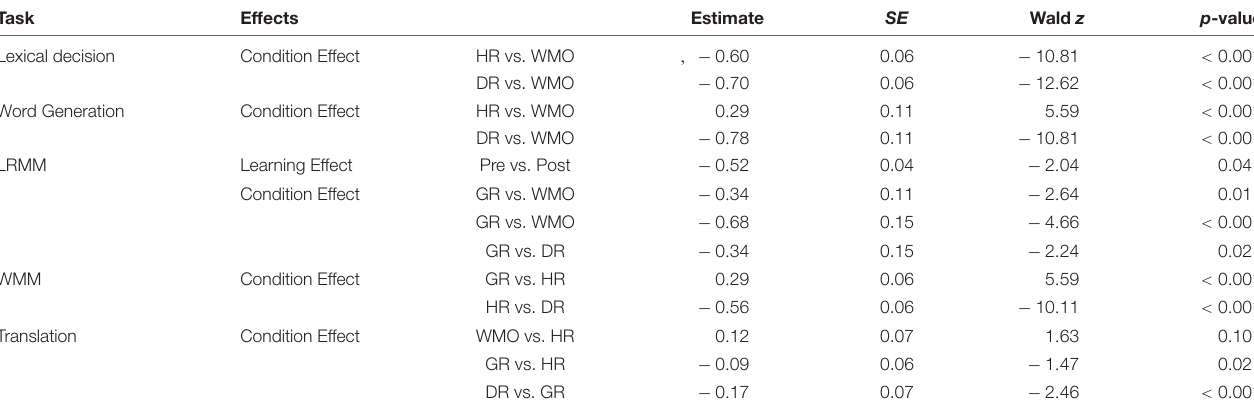
TABLE 3 | Significant fixed effects estimates from mixed Logit model of correctness with pre-planned comparisons of condition as fixed effects for five tasks. Task